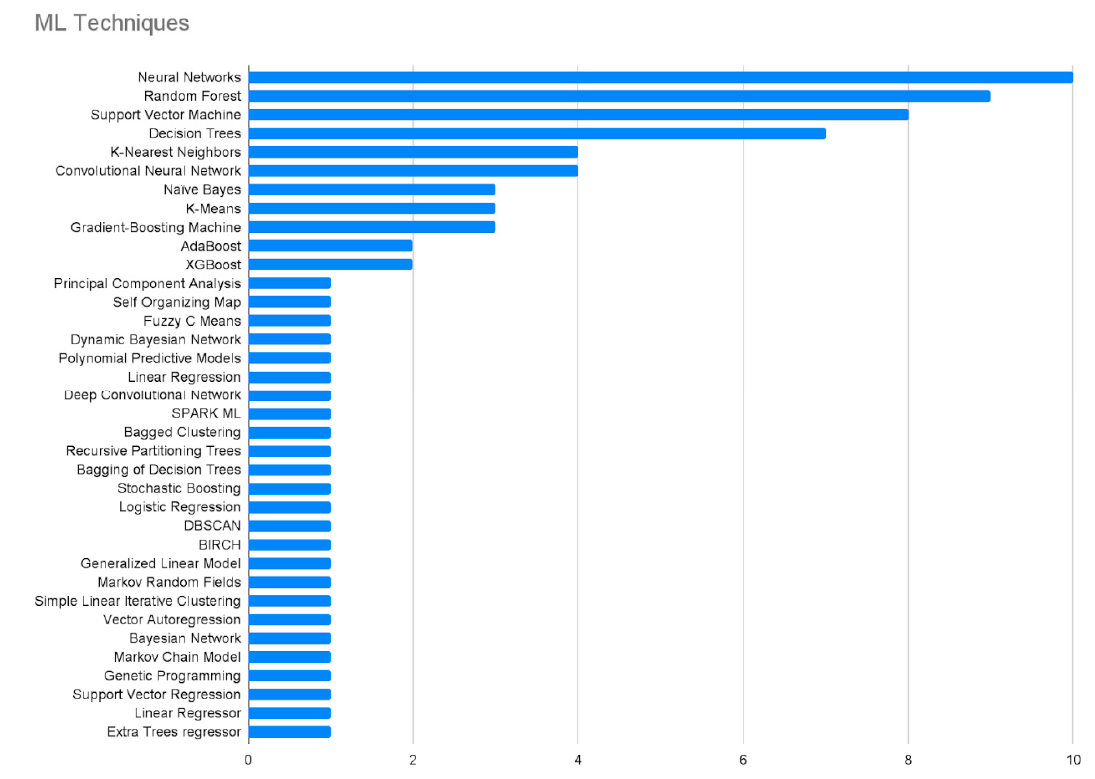
Figure 11. Main problems to be solved vs. agriculture.